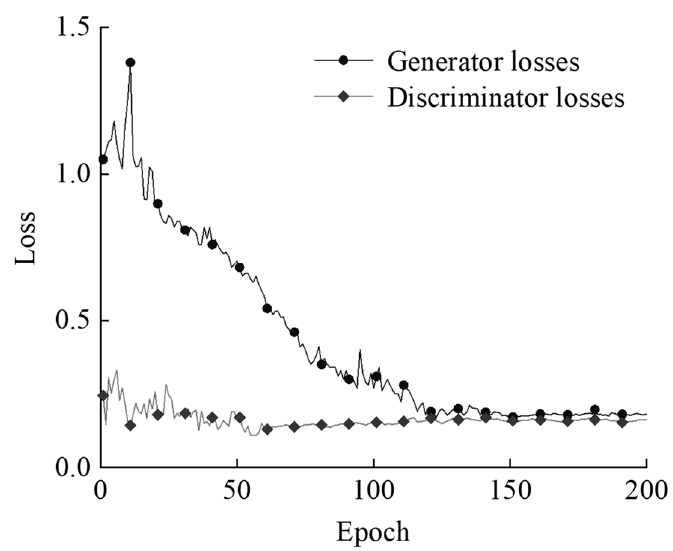
Figure 8. EBGAN loss value.